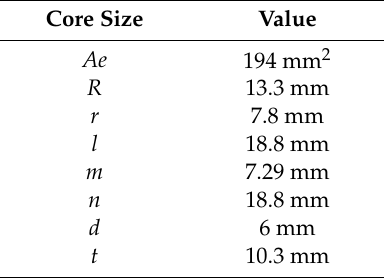
Table 4. Parameter design of the asymmetric resonant